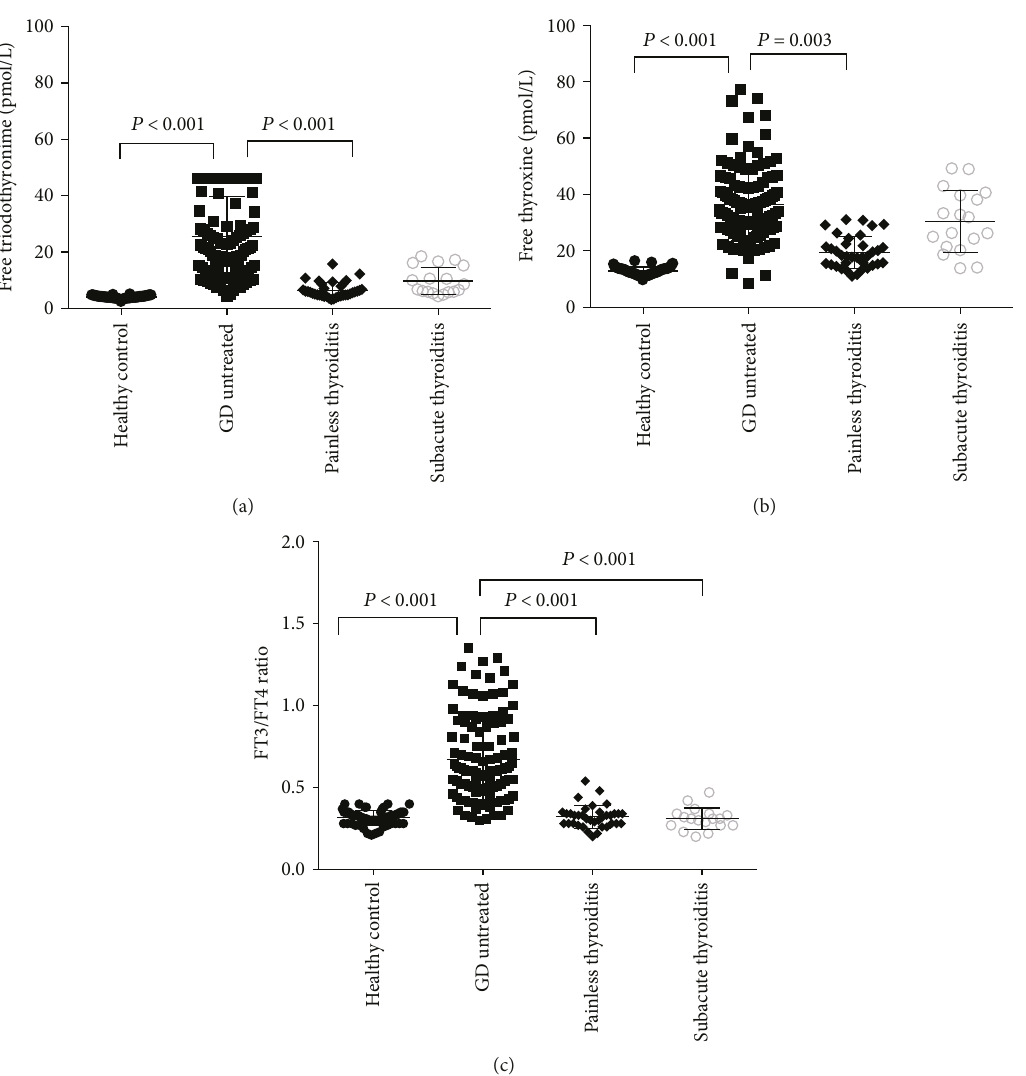
Figure 1: FT3, FT4, and FT3/FT4 ratios in di ff erent groups of patients with thyrotoxicosis at initial of diagnosis and in healthy controls. (a) shows serum free triiodothyronine (FT3) levels. (b) shows serum free thyroxine (FT4) levels. (c) shows FT3/FT4 ratios in di ff erent groups of patients with thyrotoxicosis at initial of diagnosis and in healthy